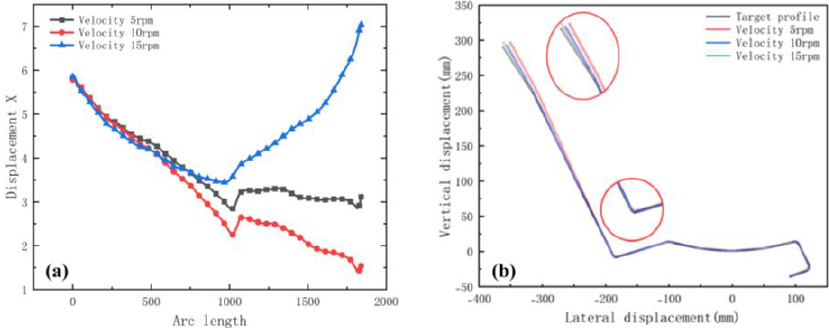
Figure 21. ( a ) Displacement X of strip in 3 velocities; ( b ) cross – section of 3 velocities.